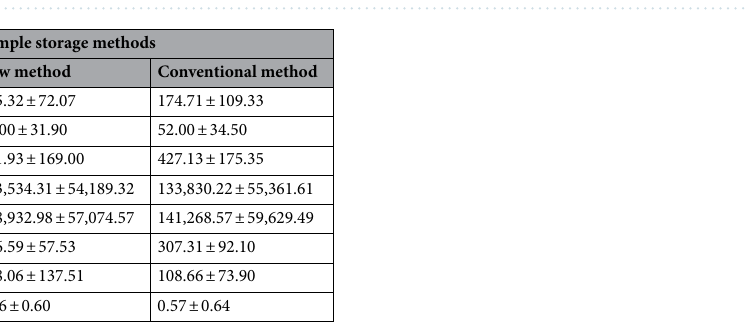
Figure 3. The concentration–time profiles for 6 healthy volunteers (NO. 1–6) after they receive one subcutaneous injection of 50 mg etanercept. 5 mL blood sample was collected in heparinized centrifuge tubes at 2, 4, 8, 12, 24, 36, 48, 72, 120, 168, 336, 504, 672, 744, and 888 h. Serum samples were separately stored using the new (red symbols and line) or the conventional method (black symbols and line) until analysis. All samples were detected with the ELISA method.